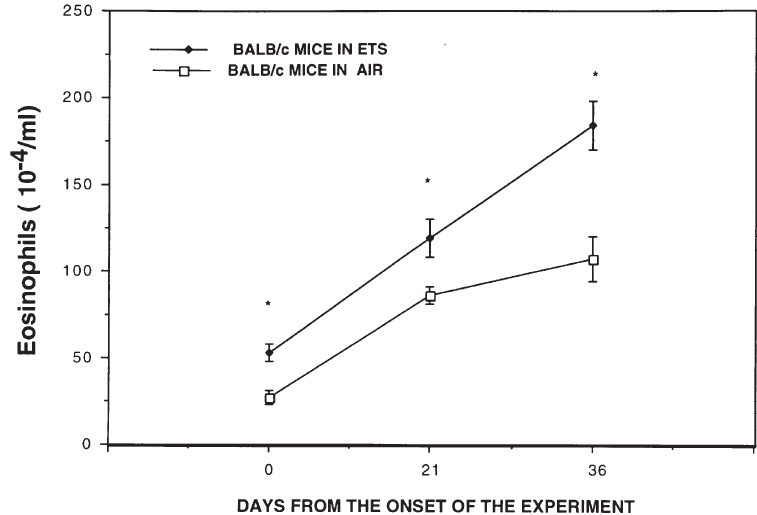
FIGURE 5 Eosinophil levels in the blood of OVA/AL sensitized mice housed in either ETS or ambient air since birth after exposure to aerosolized OVA. Asterisks indicate p , 0 : 05